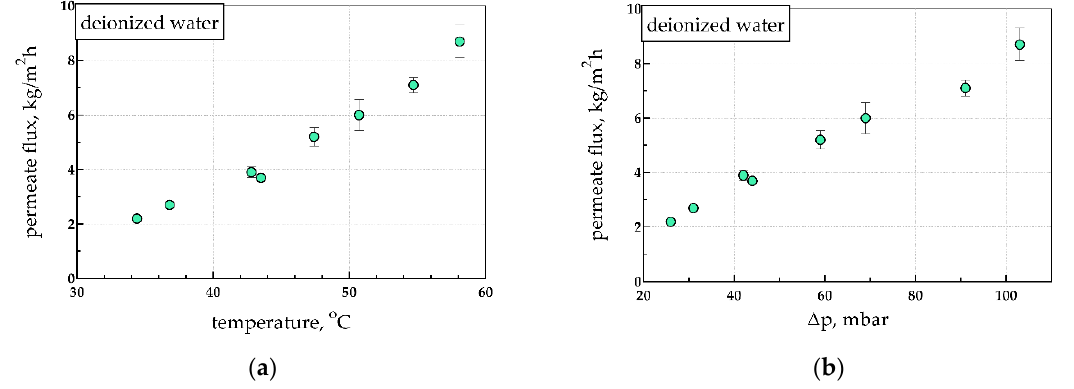
Figure 4. Permeate flux versus: ( a ) the feed solution temperature, and ( b ) the driving force (vapor pressure-applied vacuum). Data from deionized water distillation.